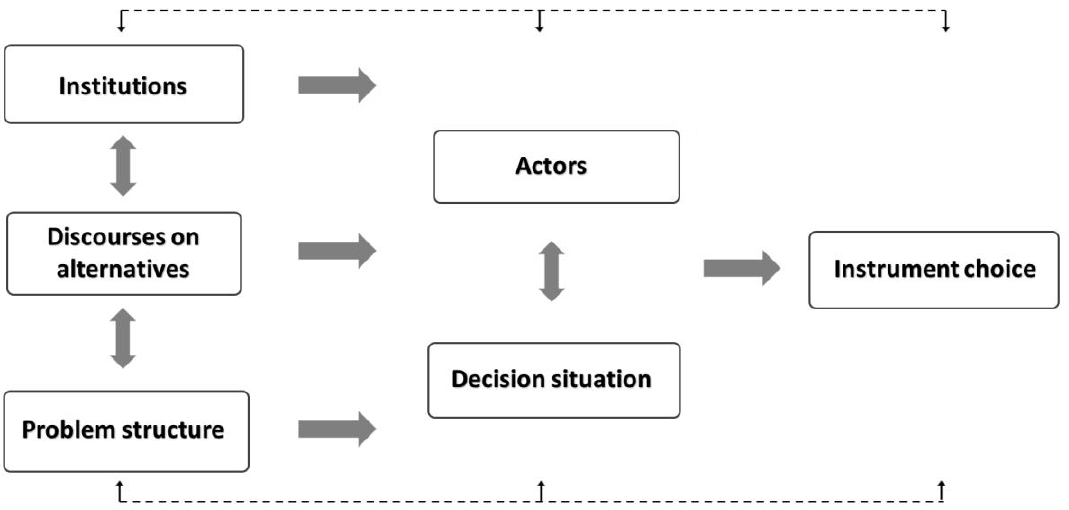
Figure 1. The instrument choice framework by Böcher and Töller, translated and slightly modified